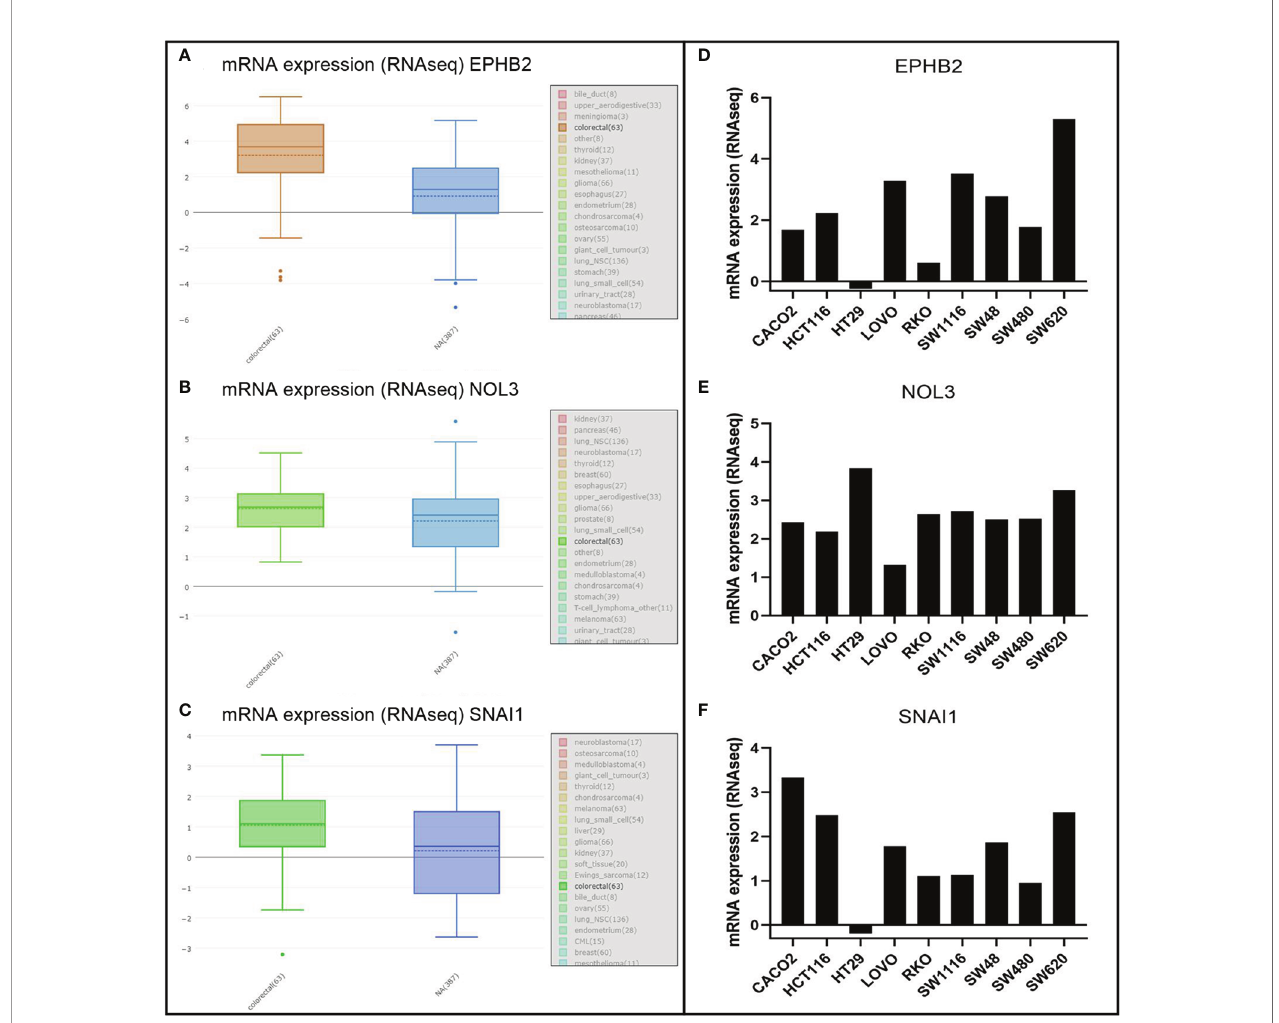
FIGURE 5 | mRNA analysis of EPHB2 (A, D) , NOL3 (B, E) , and SNAI1 (C, F) in CRC cell lines.